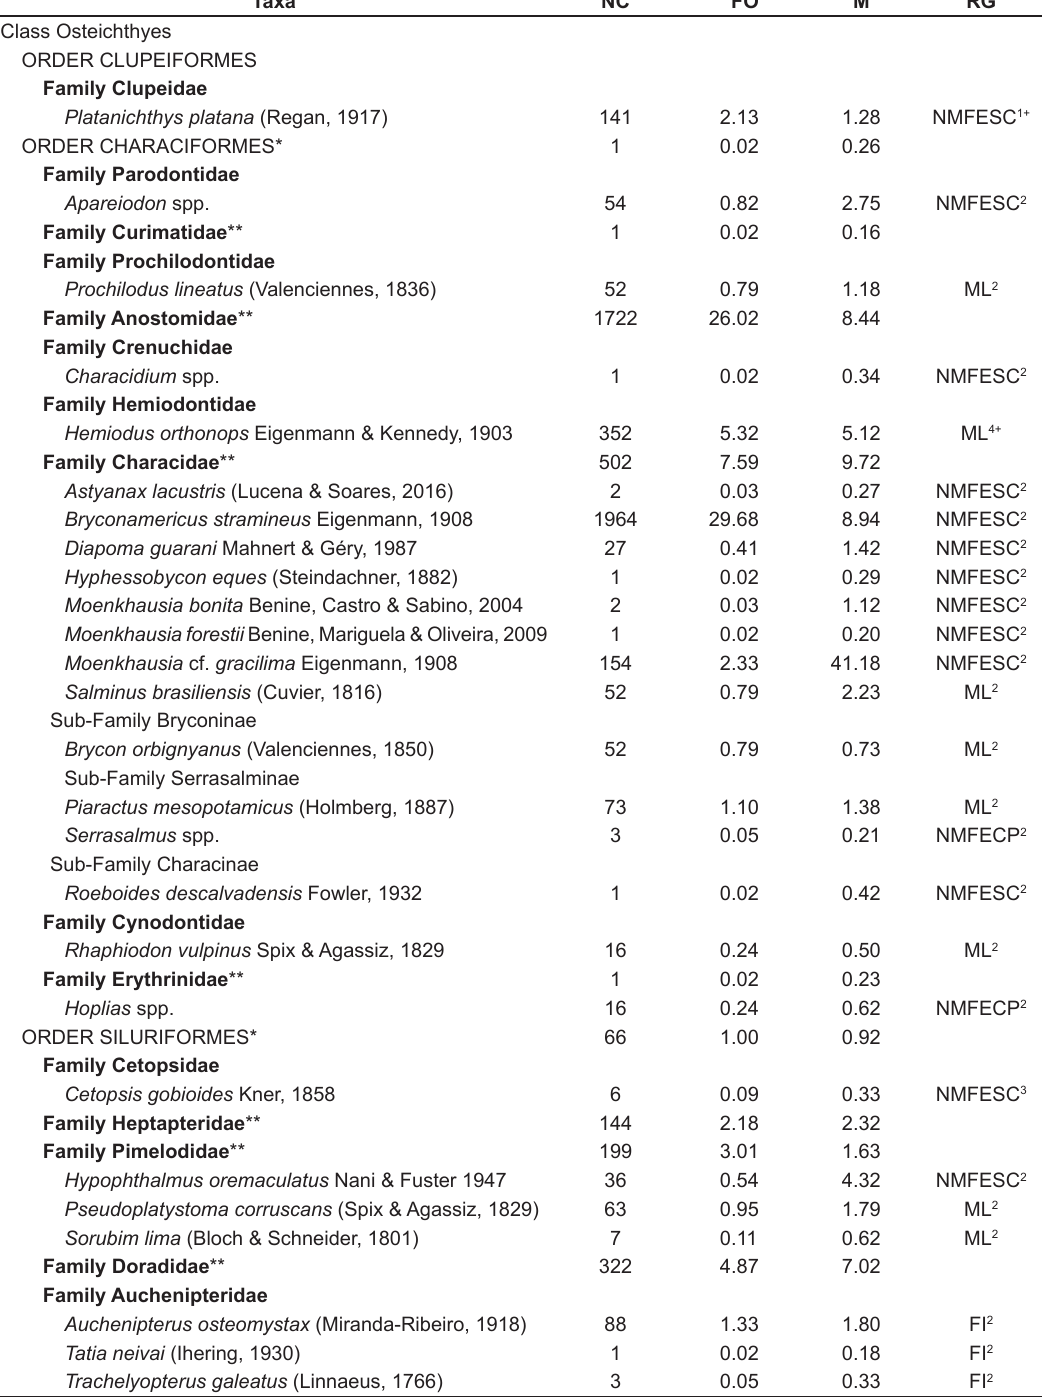
Table 2. Taxonomic composition of fish larvae caught in different environments of the Upper Paraná River floodplain between August 2013 and May 2015, with the respective number caught (NC), frequency of occurrence (FO), mean density (M), and original reproductive guild